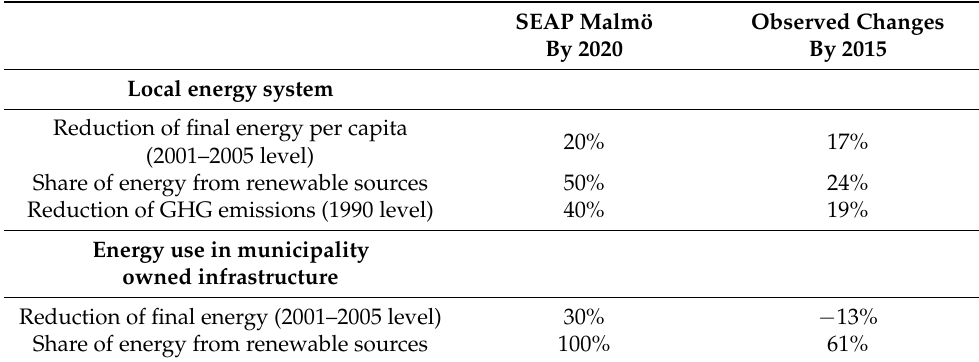
Table 7. Comparison of the overall GHG emissions reduction observed (1990–2015) and the goals established by the municipality of Malmö in the SEAP Malmö (1990–2020).